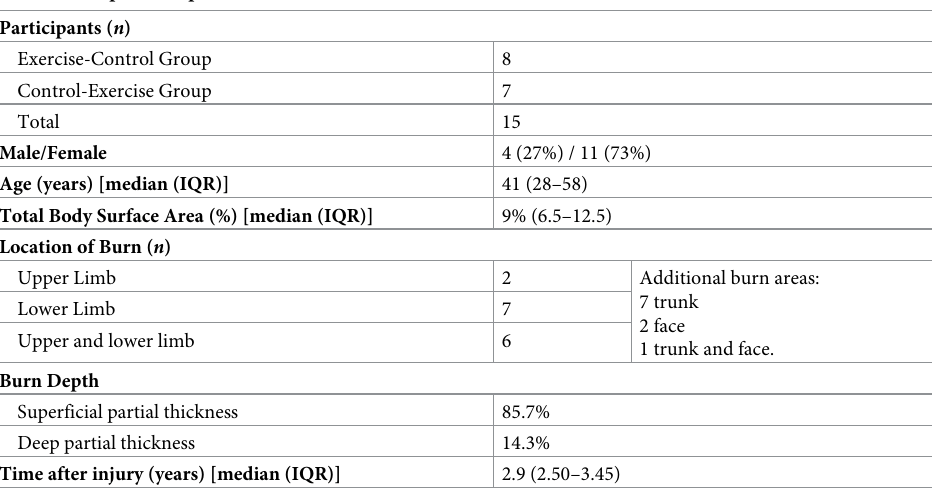
Table 1. Sample descriptive